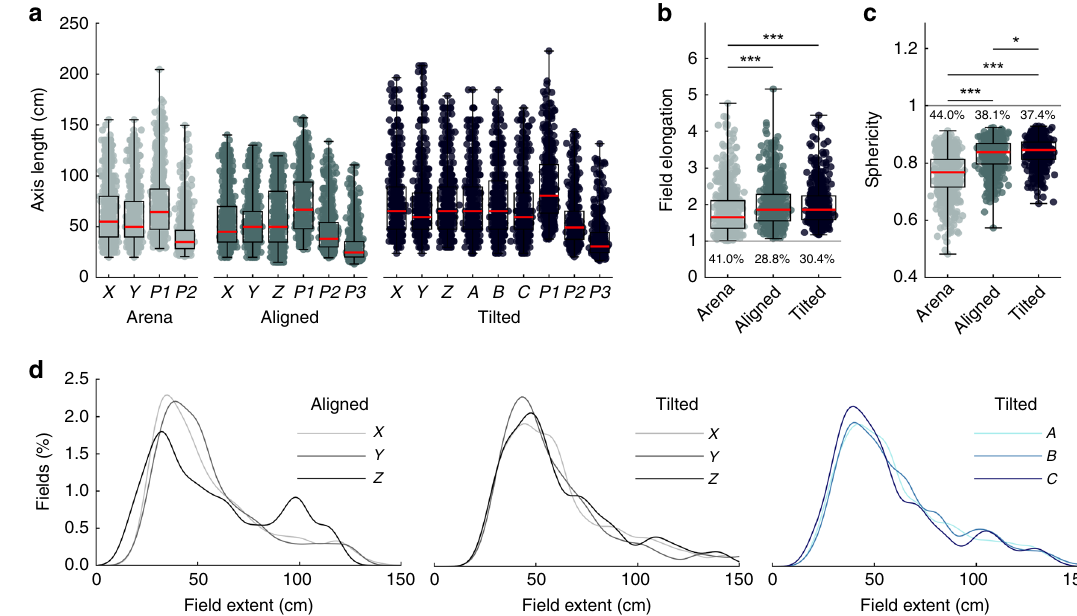
Fig. 6 The majority of place fi elds were elongated instead of spherical. Source data are provided as a Source Data fi le. Markers represent place fi elds. Omnibus test results can be seen in Table 1, post hoc test results are displayed here: *signi fi cant at the 0.05 level, **signi fi cant at the 0.01 level, ***signi fi cant at the 0.001 level. a Cartesian axis and principal axis lengths of place fi elds in all three mazes (P1-3 are the principal, semi-major and semi- minor axes respectively). b Elongation index of all place fi elds in each maze. An index of 1 (gray line) would indicate a spherical fi eld, higher values indicate elongation. The percentage of fi elds that are equally or more spherical than would be expected by chance is given by the text below each boxplot. c Same as b but for sphericity. Values <1 indicate deviation away from a sphere. d Probability density functions of the XYZ and ABC fi eld length data in a . The distribution of Z lengths differs signi fi cantly from X and Y in the aligned lattice and the distribution of Z lengths appears to be bimodal (Supplementary Data: Field elongation). In the tilted lattice there are no differences between X , Y & Z or A , B & C . See Supplementary Fig. 7 for further fi eld elongation